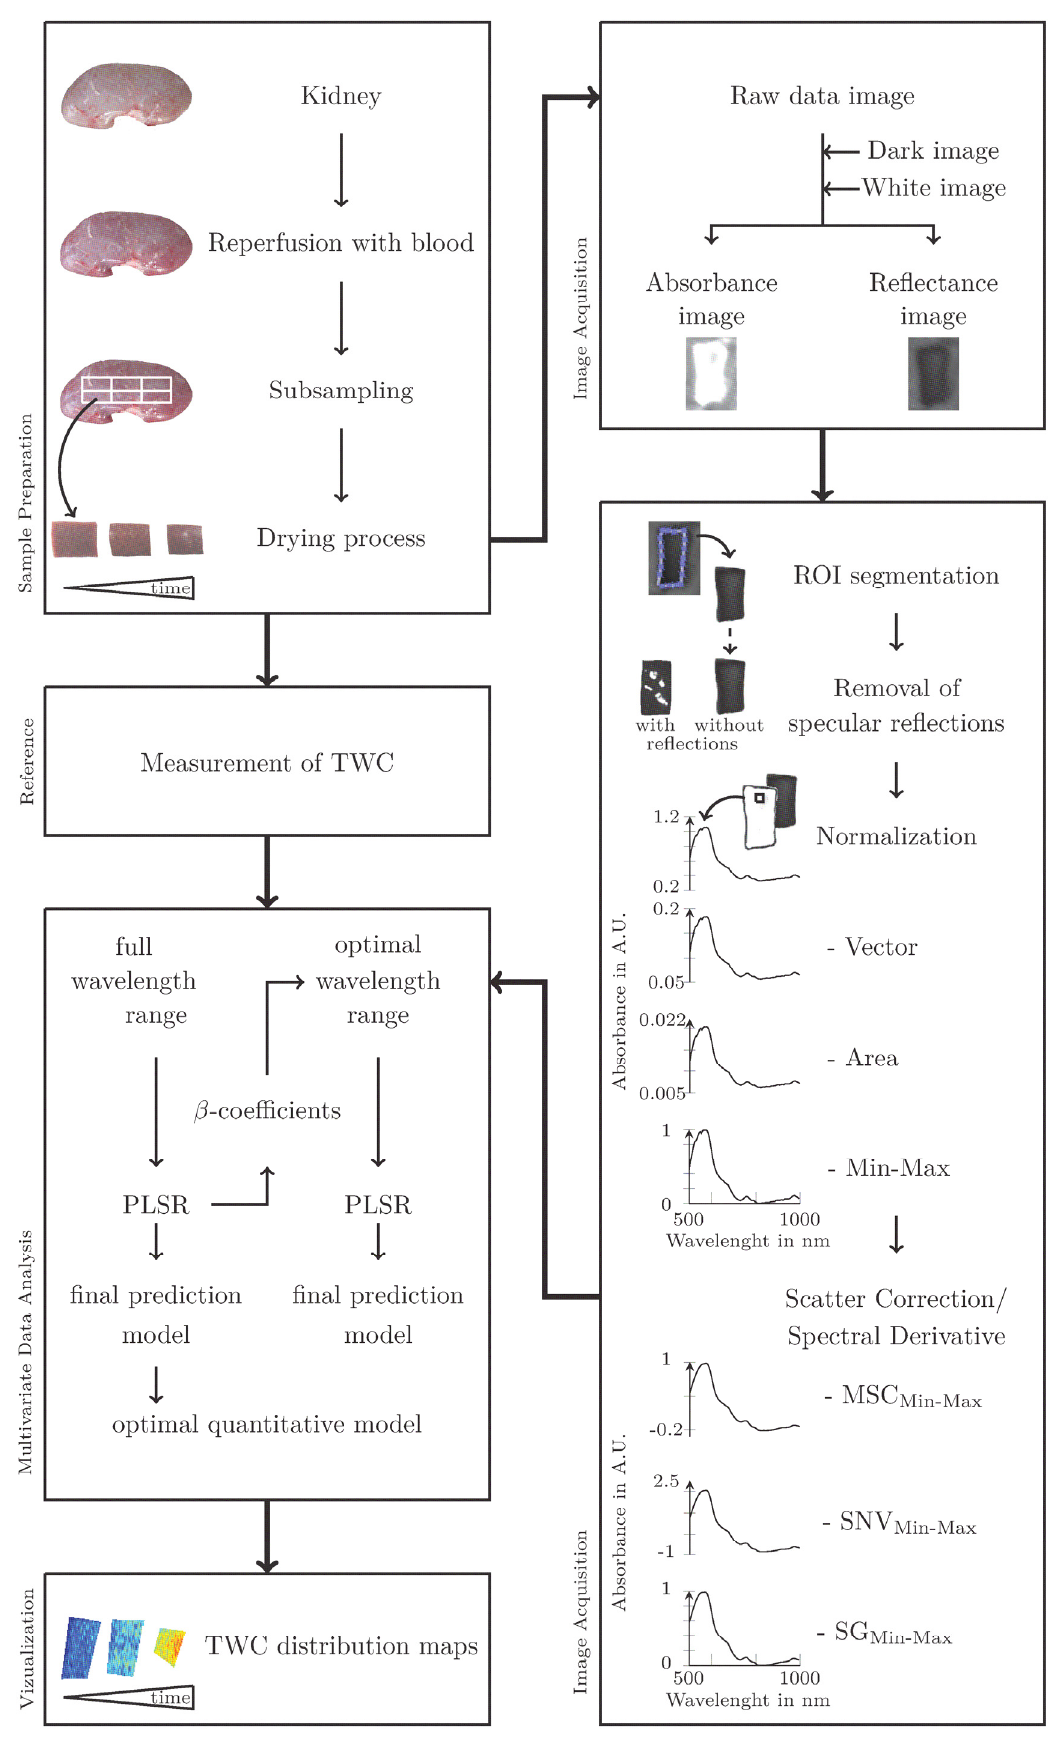
Figure 1. Main steps for TWC determination using HSI.